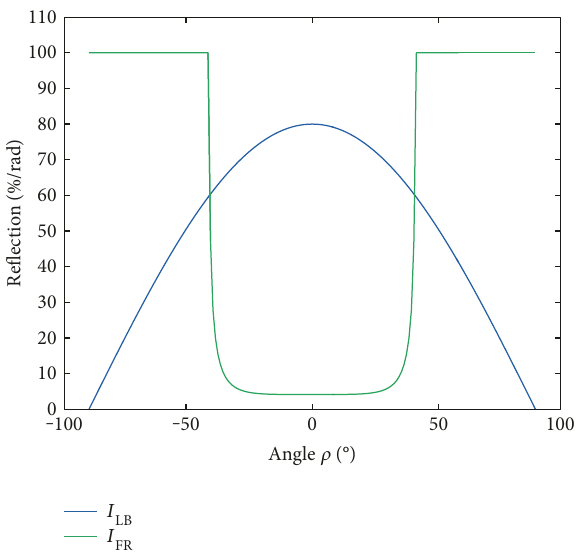
Figure 6: Module e ffi ciencies for di ff erent cell partitions ( n -times 1/ n partial solar cells) and two di ff erent cell LB